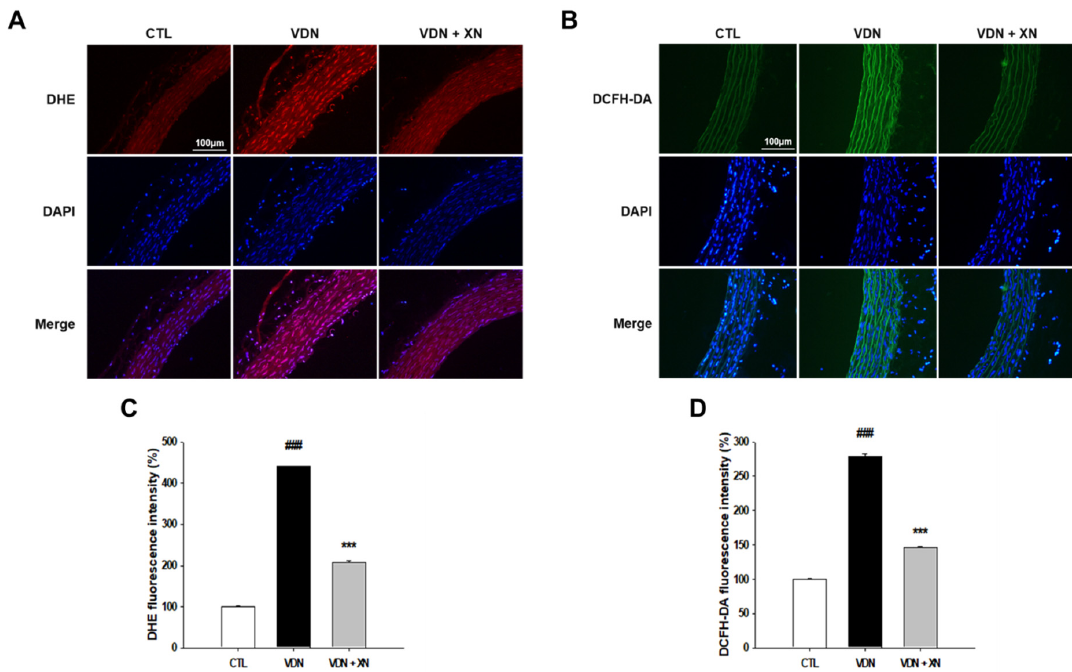
Figure 7. E ff ects of XN on oxidative stress markers through confocal microscopic observation of nuclear thoracic aorta wall. ( A ) DHE staining to detect anion superoxide generation, ( B ) DCFH-DA staining to identify H 2 O 2 production (magnification 200x), ( C ) quantified DHE fluorescence intensity, and ( D ) quantified DCFH-DA fluorescence intensity, relative to number of nuclei. Counterstaining of nuclei with DAPI in blue was merged into all images. Each point represents the mean ± SEM, n = 6. ### p < 0.001 compared with the control group. *** p < 0.001 compared with VDN group.